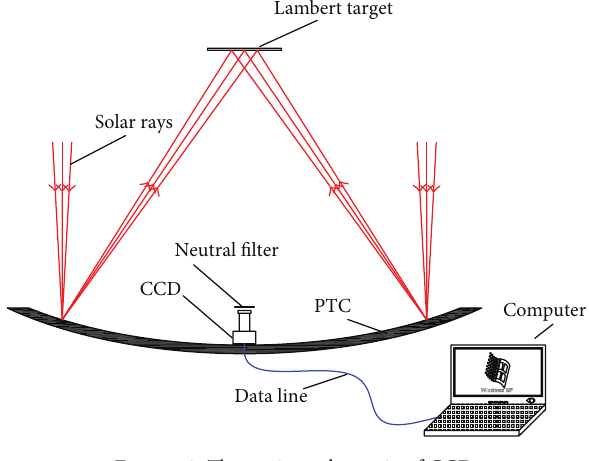
Figure 8: The testing schematic of CCD.